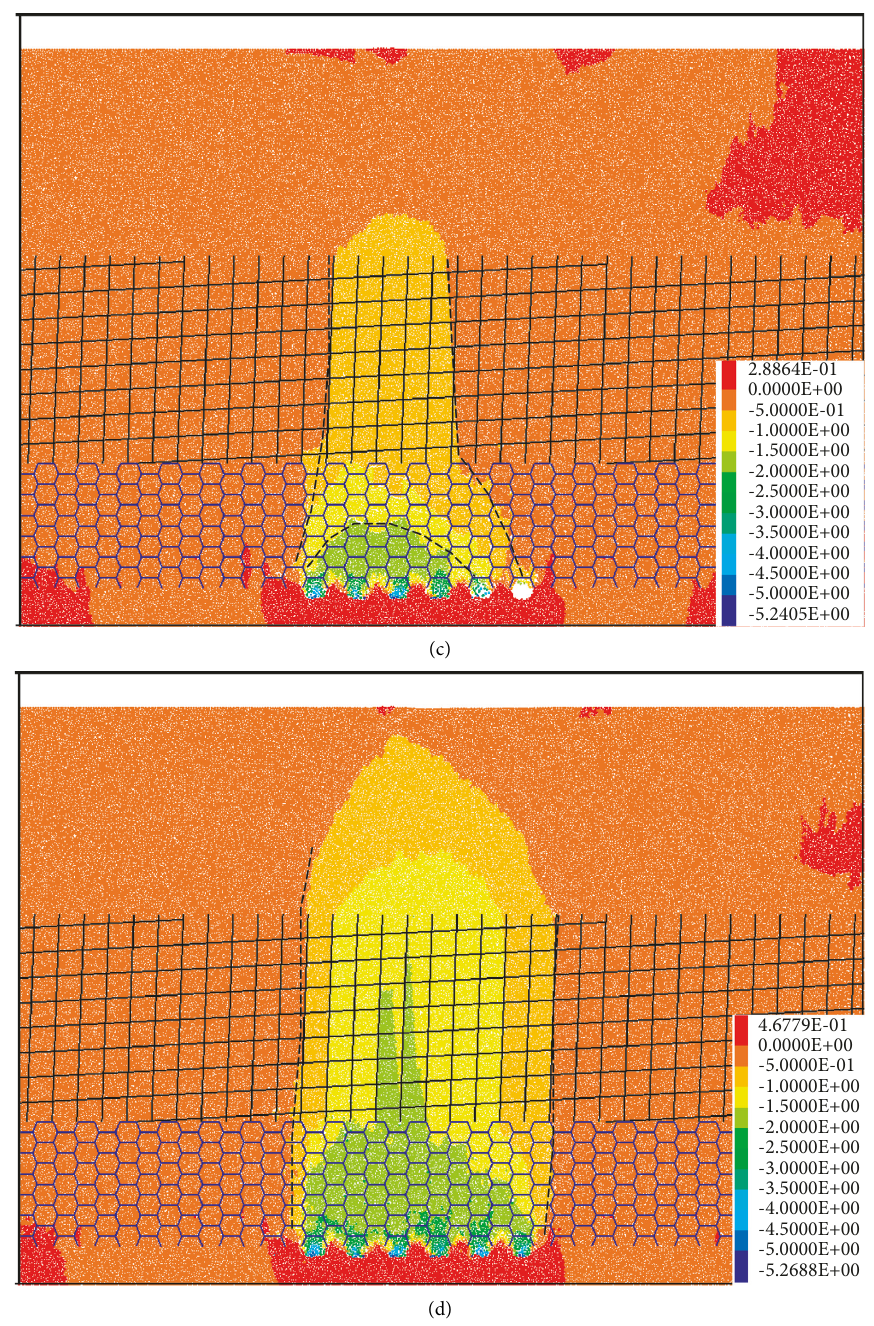
Figure 17: Displacement cloud diagram of the model during mining process. (a) Steady state of the roof. (b) Arch caving of roof filling body. (c) Initial stage of plug subsidence of overlying gneiss. (d) Late stage of plug subsidence of overlying